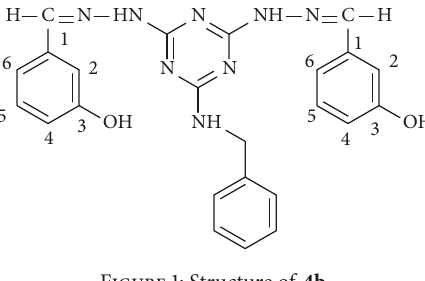
Figure 1: Structure of 4b